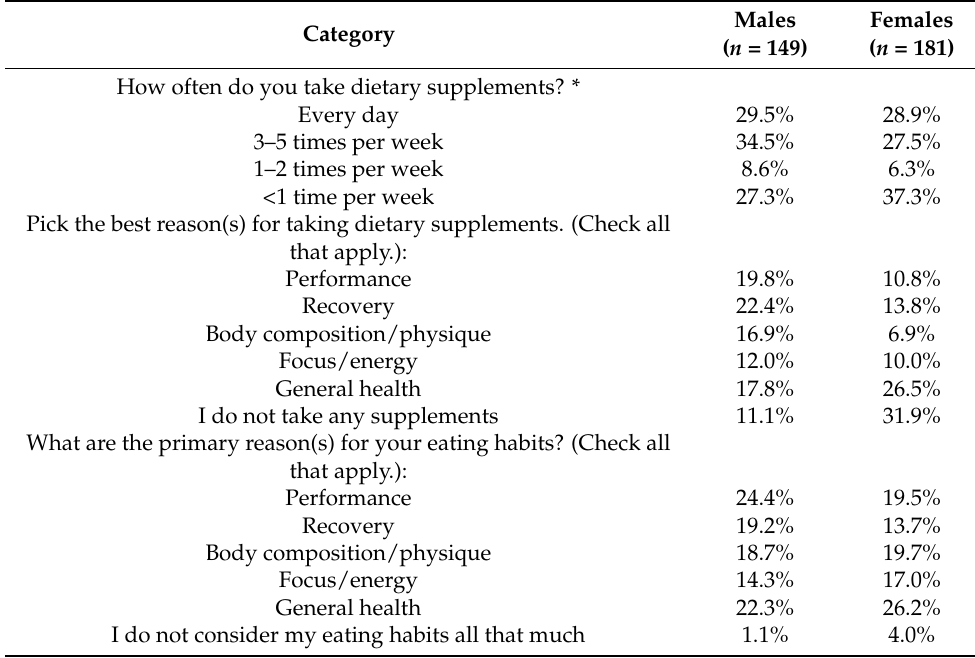
Table 5. Motivations for dietary habits and supplementation use.